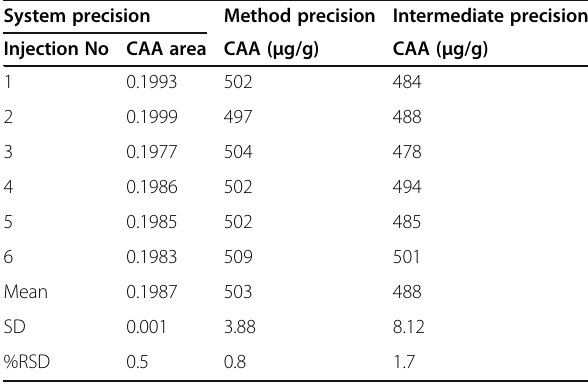
Table 5 Statistical data of precision for CAA System